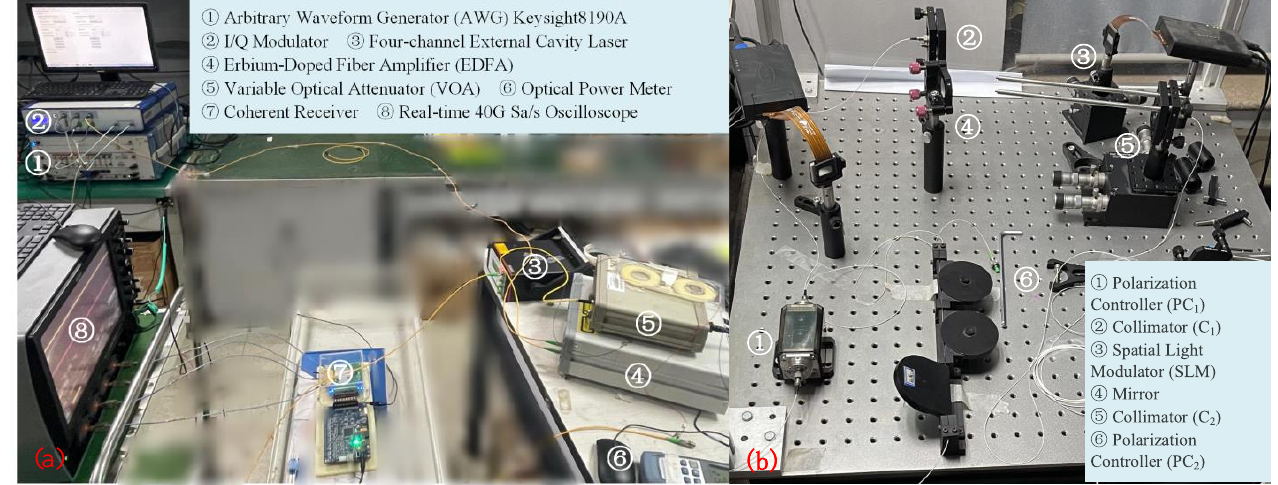
Figure 10. Laboratory system scenario diagram: ( a ) transmitter, receiver, and ( b ) atmospheric-turbulence-simulation optical-experiment platform.